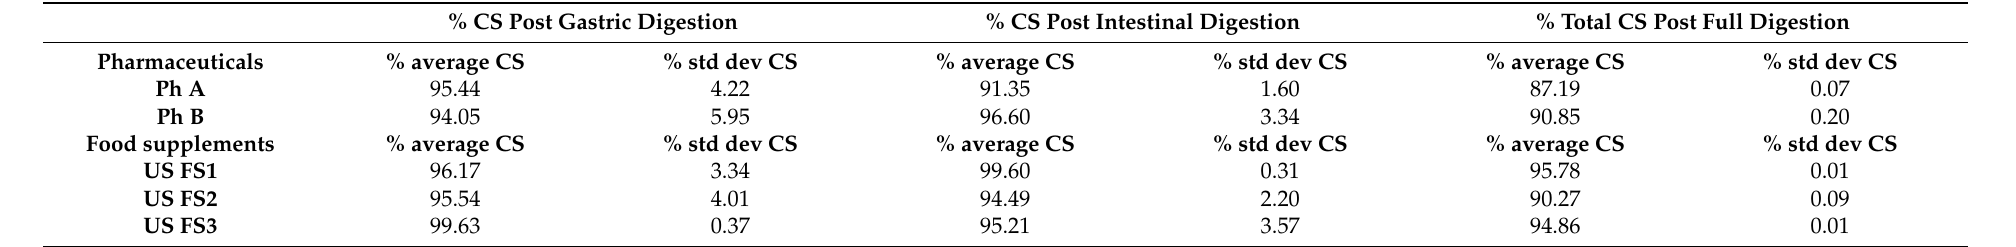
Table 3. Percentage values, with standard deviations, of chondroitin sulfate in pharma grade samples and in US food supplements after simulated gastric digestion, after simulated intestinal digestion and the calculated total CS percentage after the two